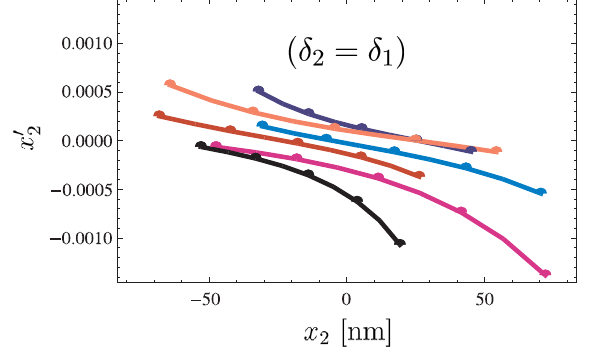
FIG. 11. (a) Time dependence of the focusing force in a FODO- R 8 O R 5 þ 1 = 2 þ 1 = 2 like DLA cell (Fig. 6). (b) Harmonic oscillation leading to classical ponderomotive